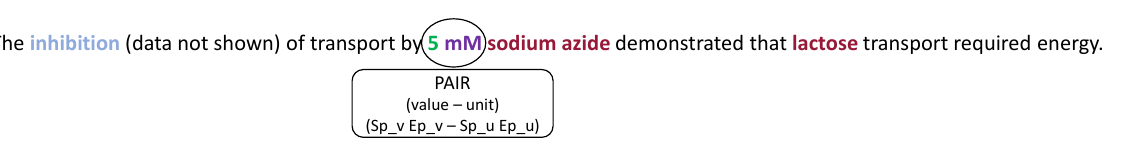
Figure 5: Example of a sentence with one value-unit pair. Annotated entities from “metabolites” (dark red) and “kinetic parameters” (light blue) classes. SP v and Ep v are respectively start and end position of the value in the sentence; Sp u and Ep u represents the same for the unit